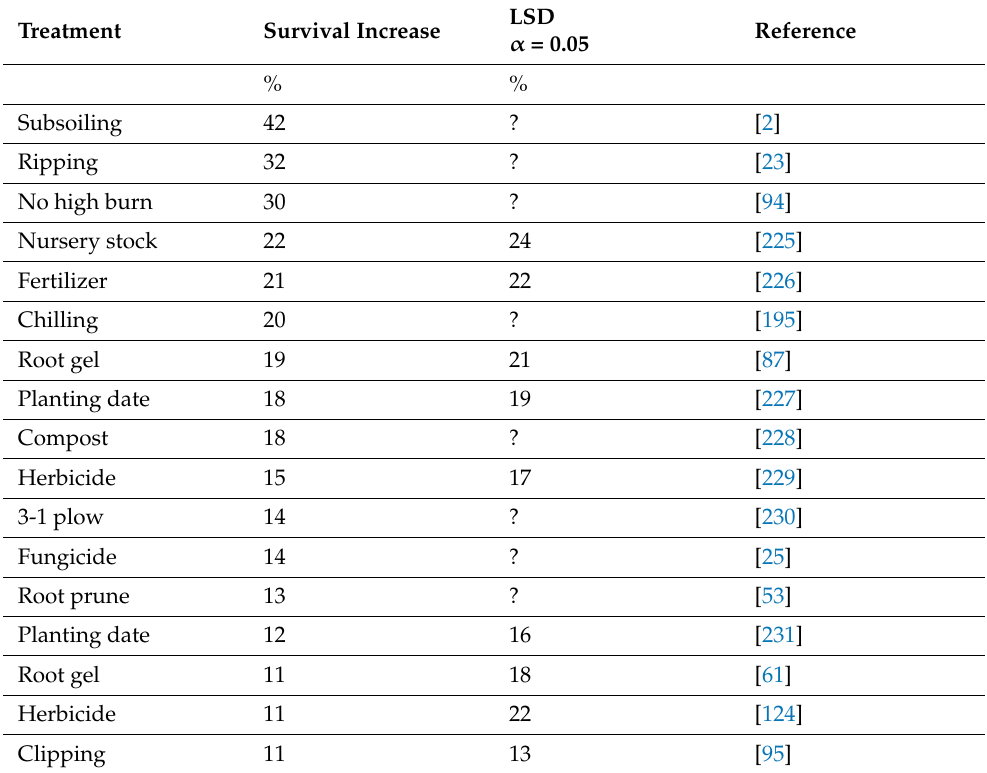
Table 3. When trials have low statistical power [224], a real 10% increase in survival is often declared not significant due to the experimental design and/or method of statistical analysis. Increases listed below were not statistically significant ( α = 0.05; two-tailed test). LSD = least significant